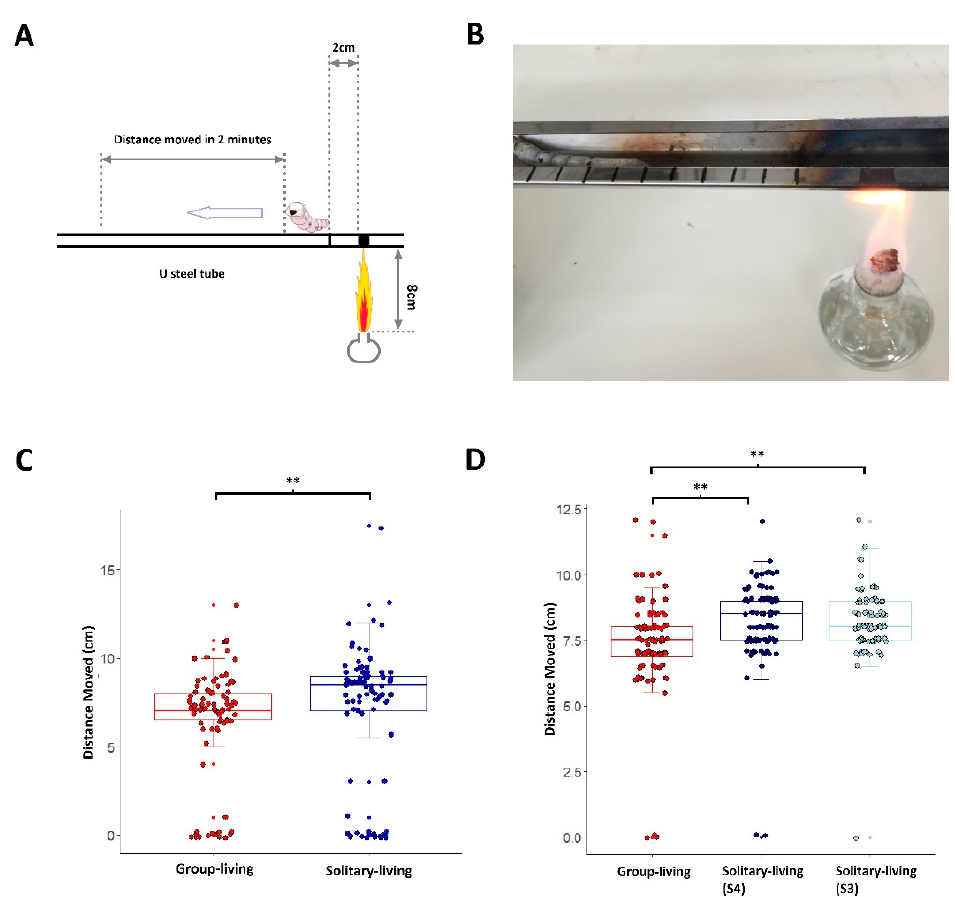
Figure 3. The difference in distance moved under heat stress between solitary and group-living silkworms. A is a sketch showing the details of the device used to test the movement of a silkworm under heat stress. ( B ) is a picture of a real product of ( A ). ( C ) shows the difference in the distance moved between solitary and group-living silkworms. ( D ) shows the distance moved for group-living silkworms, S3 and S4 solitary silkworms. In ( C , D ), ‘**’ denotes p -value < 0.01. Statistics are performed by Wilcox test.